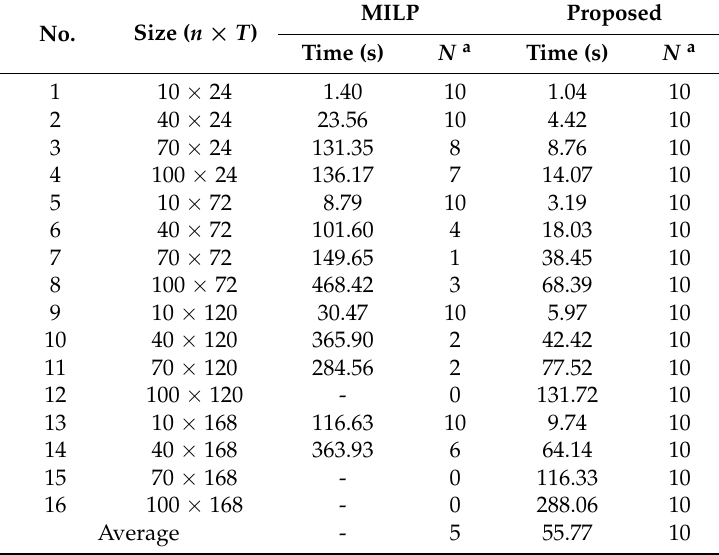
Table 2. The computation time and the number of cases that can be solved optimally for the MILP approach and the proposed